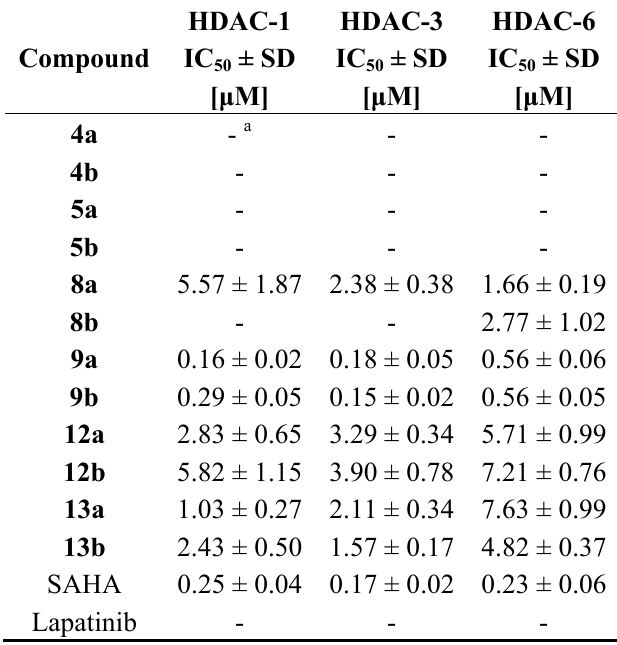
Table 1. In vitro HDAC Inhibition.